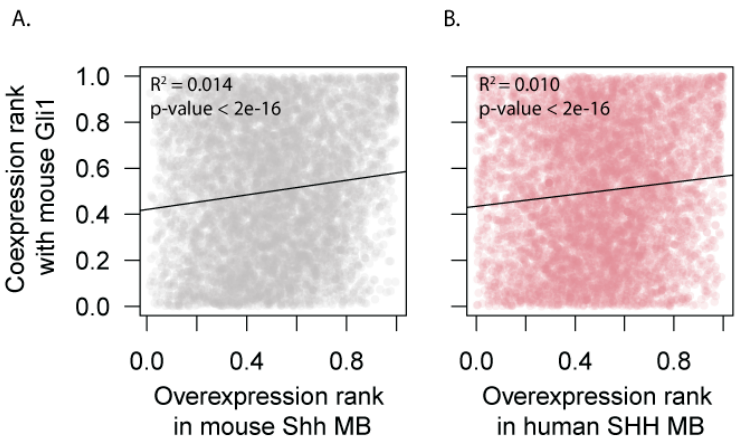
Figure 4. Mouse Hedgehog (HH) target genes are upregulated in both human and mouse Shh-MB. Genes were ranked according to their likelihood of being Shh targets in the mouse based on their coexpression patterns with the canonical Shh target Gli1 (y-axis) and ranked according to their overexpression in mouse Shh-MB (x-axis in A ) or in human SHH-MB (x-axis in B ). The rank R2 value is significantly different from 0 in both cases.